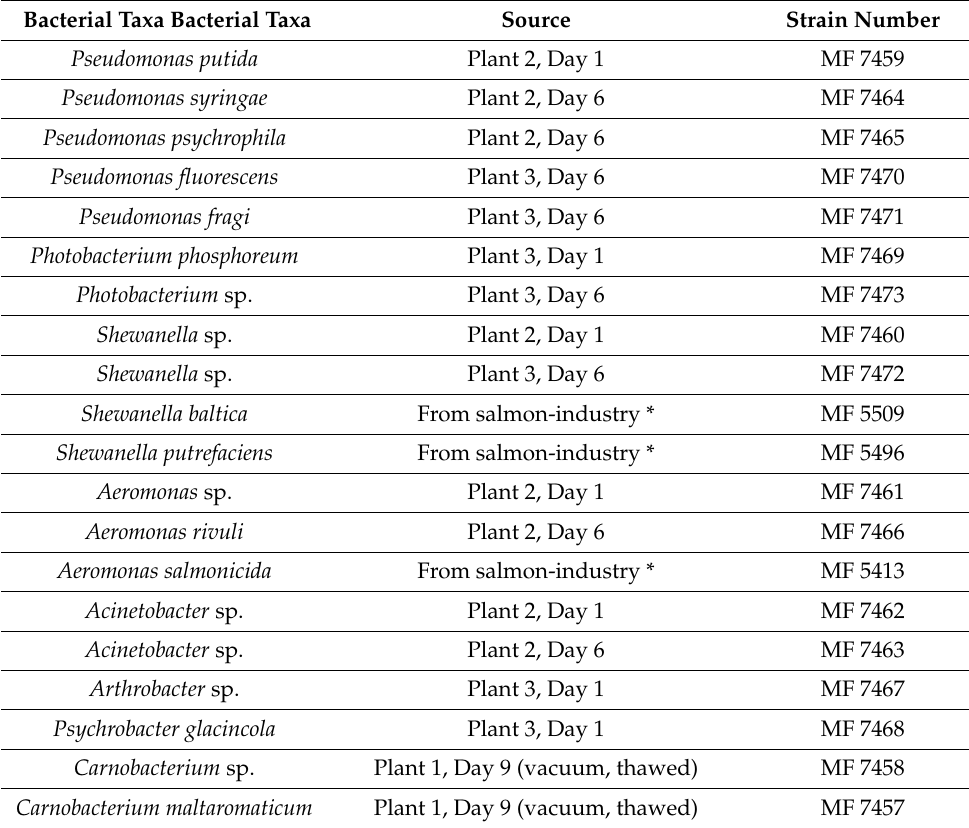
Table A1. Bacterial strains (20) used in growth screening on cod agar plates at different packaging gas mixtures. The bacterial strains were selected from the fillets from Plant 2 and 3 (aerobically stored fillets), which were the commercial processing plants, but similar strains were also detected from Plant 1. Two strains were from vacuum packaged fillets of Plant 1. Three strains were chosen from former industrial studies (*).